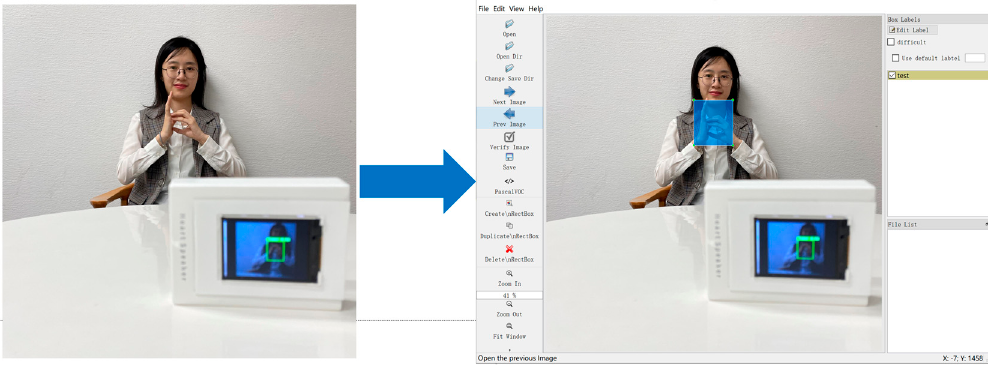
Figure 8. Sample data for the database.